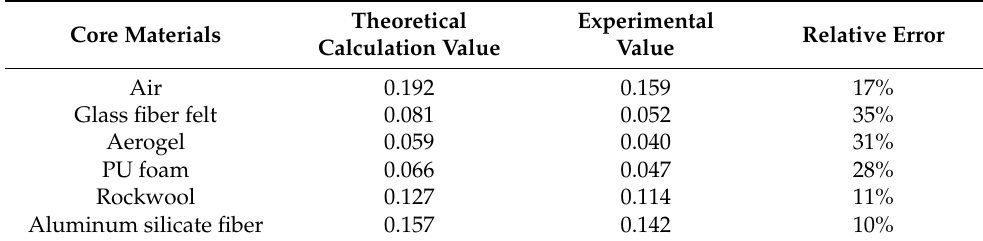
Table 4. The effective thermal conductivity of corrugated sandwich panels with different filling materials.